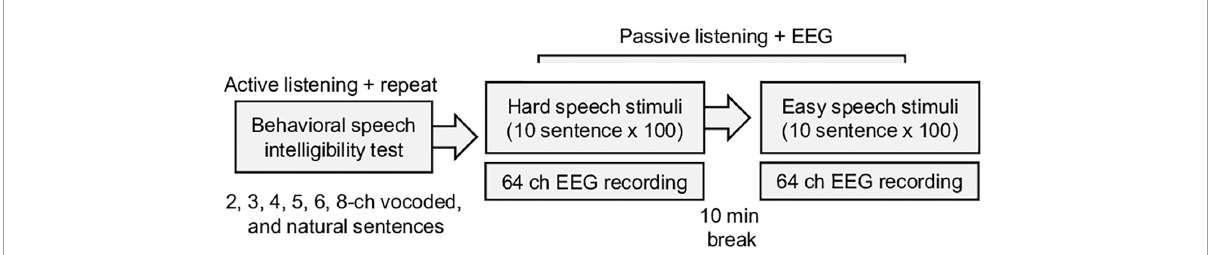
FIGURE1 Summary of the experimental procedure for the behavior speech intelligibility test and EEG recording. During the behavioral test, vocoded noise, and natural sentence speeches are randomly played, and the participants are asked to repeat the sentences. The electroencephalogram (EEG) responses to the speech stimuli are recorded during the passive listening